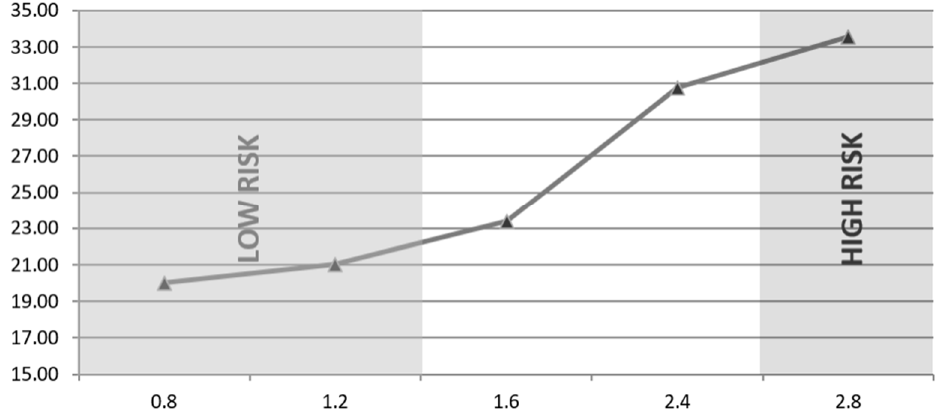
Figure 5. Fourier transformed averages of peak values ( µ V) on horizontal axis versus the LI on vertical axis.